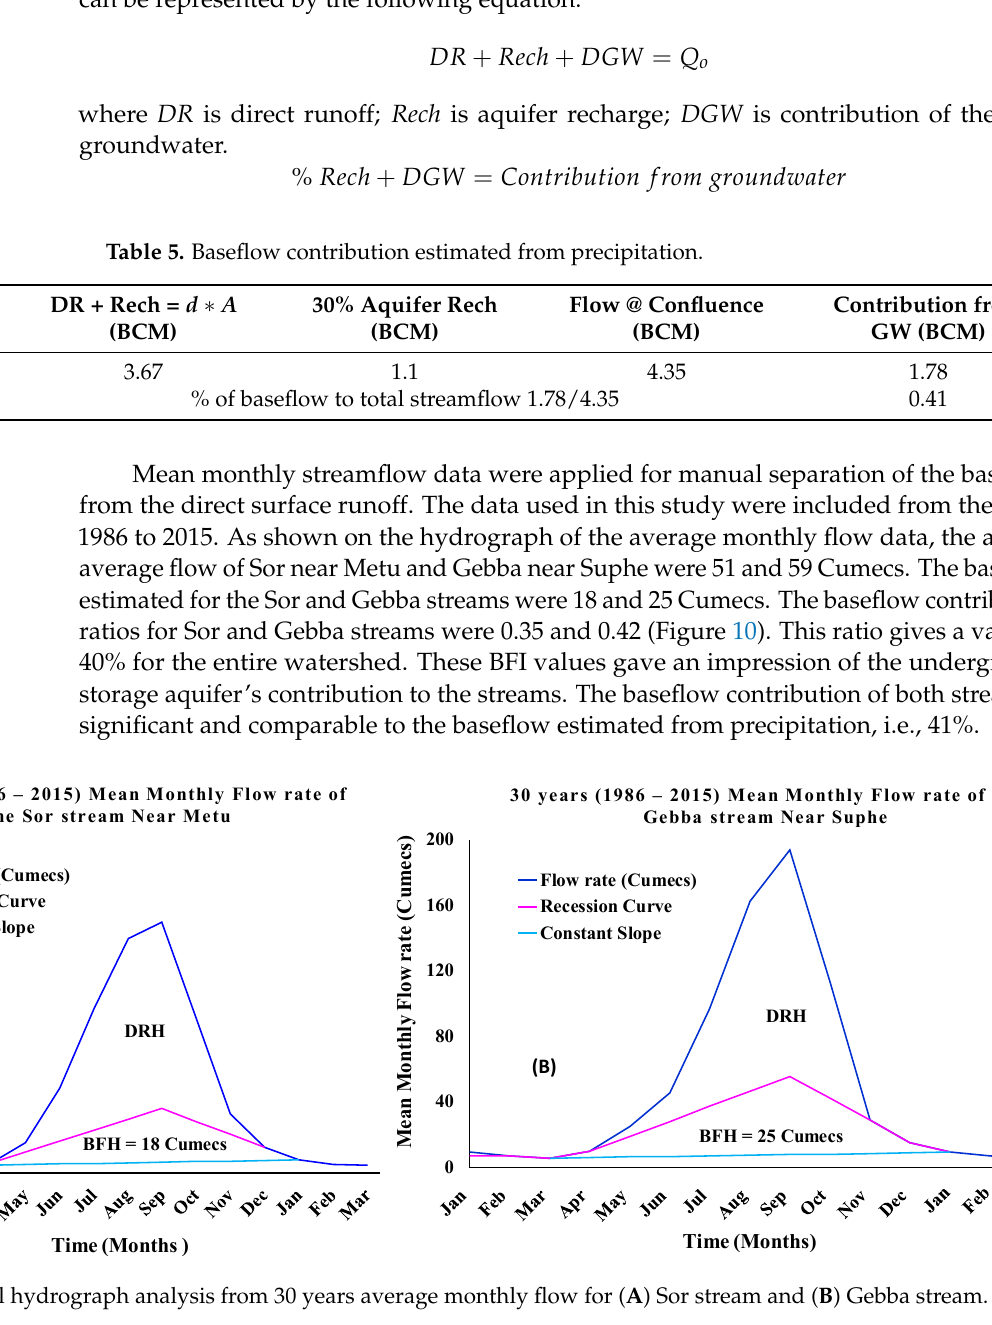
Figure 10. Manual hydrograph analysis from 30 years average monthly flow for ( A ) Sor stream and ( B ) Gebba stream.